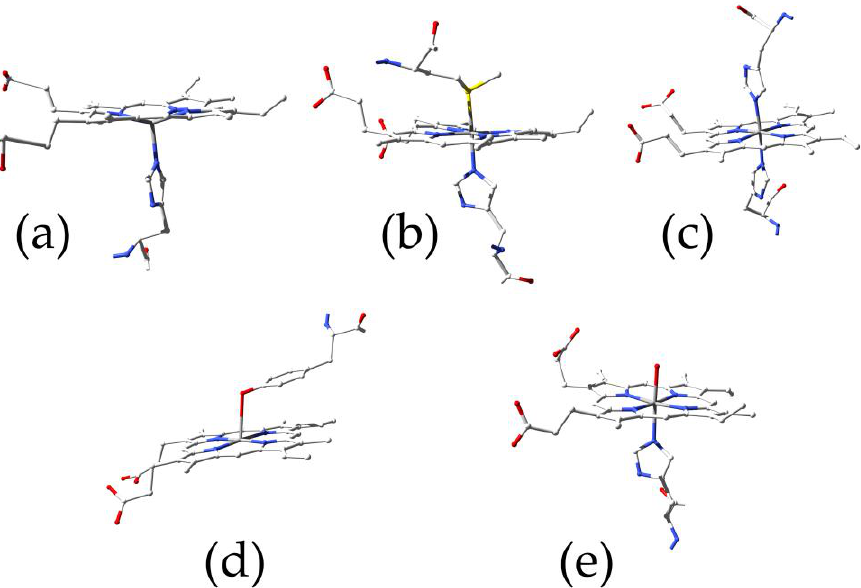
Figure 1. Principal heme coordination modes: ( a ) globins (PDB ID 4HHB); ( b ) cytochromes (PDB ID 3ZCF); ( c ) hemopexin (PDB ID 1QHU); ( d ) serum albumin (PDB ID 1O9X); ( e ) nitrobindin (PDB ID 6R3W).